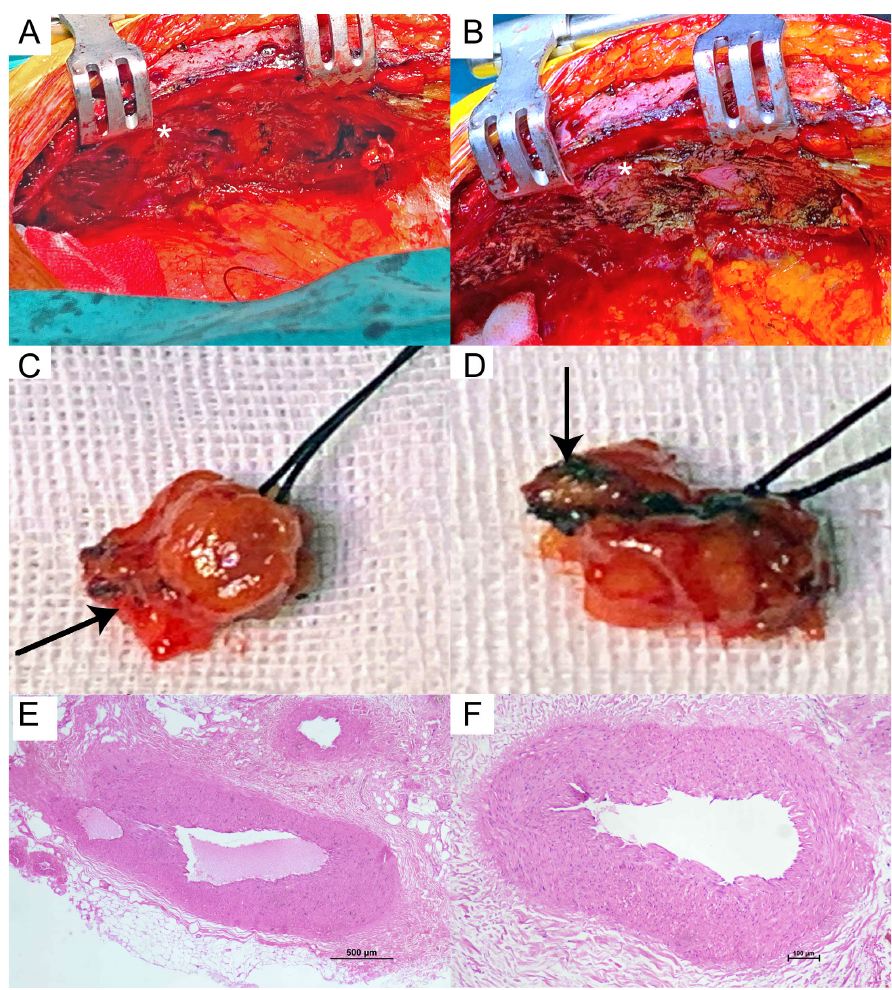
Fig. 2 - Intraoperative images. A) Image of the subcostal tissue after harvesting left internal mammary artery (LIMA) using the low-thermal plasma dissection device (or plasma kinetic cautery [PKC]) shows the presence of minimal thermal damage to the surrounding tissue (white asterisk). B) Image of the subcostal tissue after harvesting LIMA by the conventional monopolar electrosurgery (CMES) showing the presence of serious thermal damage to the surrounding tissue; burnt tissue can be clearly observed (white asterisk). C) Intraoperative image of excised thymus tissue by PKC incision shows a sharp cutting edge without any burning. D) Intraoperative image of excised thymus tissue by CMES incision shows an irregular cutting edge with significant burnt tissue. E to F) Histological features of LIMA graft after preparation with PKC (E) and CMES (F) at 500 µm (E) and 100 µm (F) represent similar findings with minimal